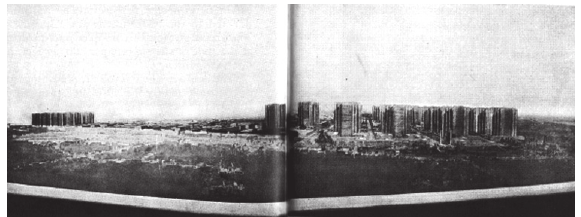
fig. 6. Diorama du Plan Voisin de Paris (Pavillon de l’Esprit nouveau à l’Exposition des arts décoratifs) (le Corbusier 1980)